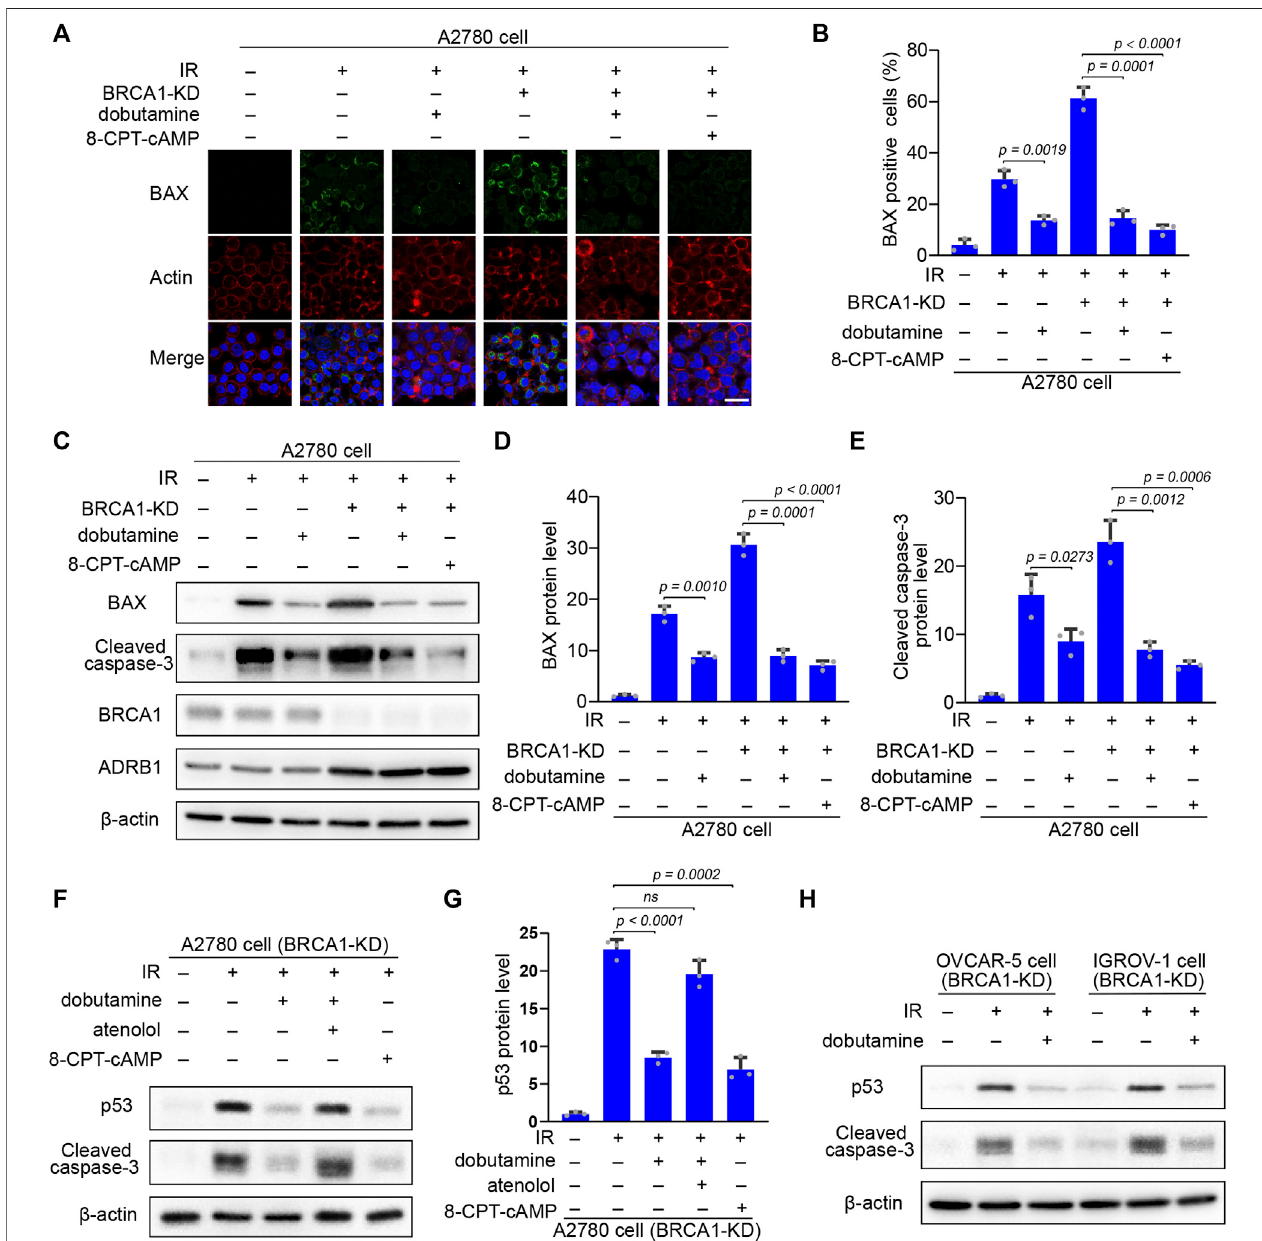
FIGURE6 | The inhibitory effect ofcAMP on IR-induced apoptosis isp53 dependent. (A) Controland BRCA1 knock-down A2780 cells were treated asdescribed in Panel 5C . 18 h after IR, immuno fl uorescence staining of pro-apoptotic pore-forming protein BAX of each cells was performed. Scale bar, 25 μ m. (B) Percentages of BAX positive cells in each group from (A) . At least 100 cells were included in each group. Three biologically independent replicates were performed. Data are presented asmeanvalues±SD. p valueswerecalculatedbyunpairedtwo-tailedStudent ’ s t -tests. (C) WesternblotanalysisofBRCA1,ADRB1,BAX,andcleavedcaspase-3 protein levelin each groupthatweretreatedasdescribedin (A) . β -actin wasused asaloadingcontrol. (D,E) Proteinlevels ofBAXand cleaved caspase-3in each group from (C) . The relative intensities of BAX and cleaved caspase-3 bands were quanti fi ed by ImageJ. The experiments were performed three times. Data are presented as mean values ±SD. p values were calculated by unpaired two-tailed Student ’ s t -tests. (F) BRCA1 knock-down A2780 cells were treated with or without dobutamine, atenolol, or 8-CPT-cAMP before exposed to 10 Gy IR. 18 h after IR, p53 and cleaved caspase-3 protein levels in each group were determined by western blot. β -actin was used as a loading control. (G) Protein levels of p53 in each group from (F) . The relative intensities of p53 bands were quanti fi ed by ImageJ. The experiments were performed three times. Data are presented as mean values ±SD. p values were calculated by unpaired two-tailed Student ’ s t -tests. (H) BRCA1 knock-down OVCAR-5 and IGROV-1 cells were incubated with or without dobutamine before exposed to 10 Gy IR. 18 h after IR, p53 and cleaved caspase-3 protein levels in each group were determined by western blot. β -actin was used as a loading control.